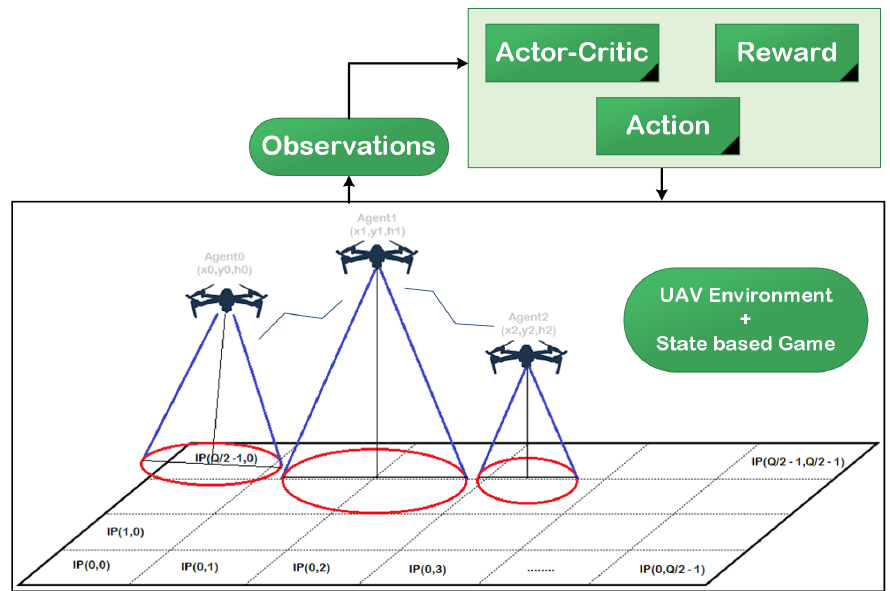
Figure 1. UAV network with the actor–critic